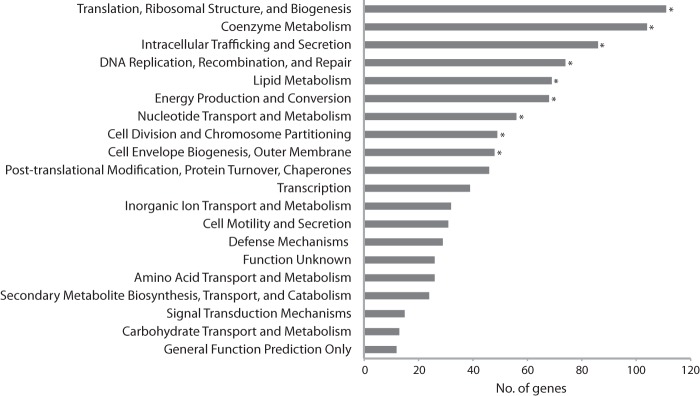
COG analysis of R. sphaeroides essential genes. The genes essential for aerobic growth on LB were binned by COG category. Asterisks (*) represent those categories that were overrepresented in the analysis (P value < 0.05, hypergeometric distribution).